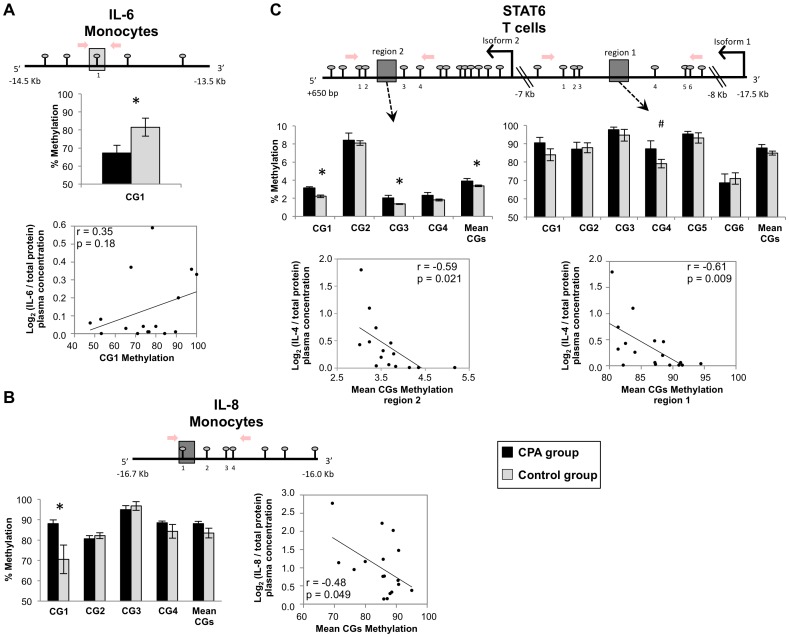
Pyrosequencing analyses of differentially methylated sequences in T cells and monocytes between CPA (n = 8) and control (n = 12) groups.DNA methylation differences (%) between the aggressive groups in the IL-6 (A), IL-8 (B) and STAT6 (C) genes as determined by pyrosequencing. CpG sites near the significant probes were analyzed in triplicate. For each gene, the mean methylation per group per CpG with the standard error of the mean (SEM) are shown in the bar graph (top panel). The rightmost bar indicates the mean methylation levels of all CpG sites analyzed in the region. A map of the sites relative to the transcription start site is shown above the bar graph. Each line with a circle represents a CpG site. The location of probes which fold difference is significantly different between the groups is identified by a grey square where dark and light grey indicated more or less methylated in the CPA group respectively. Red arrows delimit the region analyzed by pyrosequencing. Correlations between mean methylation levels obtained by pyrosequencing for each gene and expression levels in plasma obtained by ELISA for each cytokine [32] is shown in the bottom panel. Correlation statistics were performed using Pearson correlation. All error bars represent standard error of the mean (SEM). The symbol ‘#’ denotes a p-value ≤0.1 and the symbol ‘*’ denotes a p-value ≤0.05 as determined by a Student t-test.